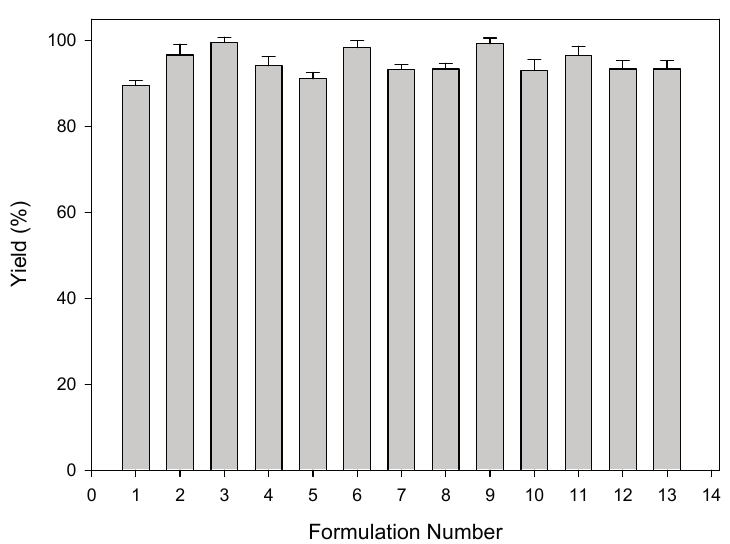
Figure 5. Nanocapsule yield of each formulation as per statistically generated design template (SD ≤ 2.52 in all cases, N = 3).